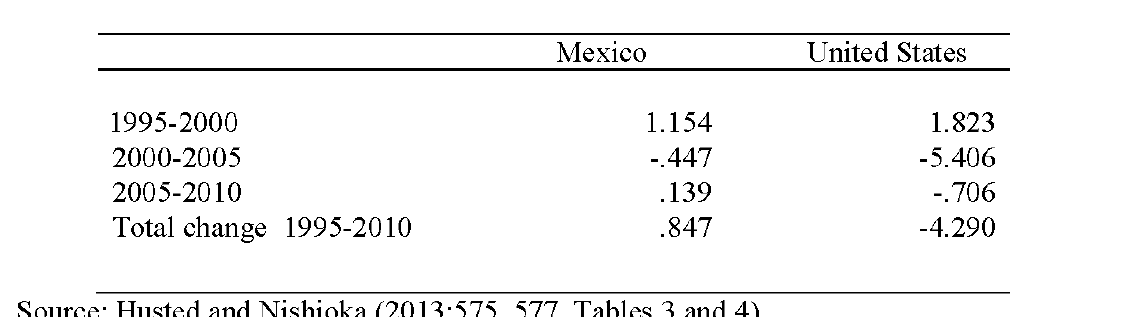
Table 1. Changes in Global Export Market